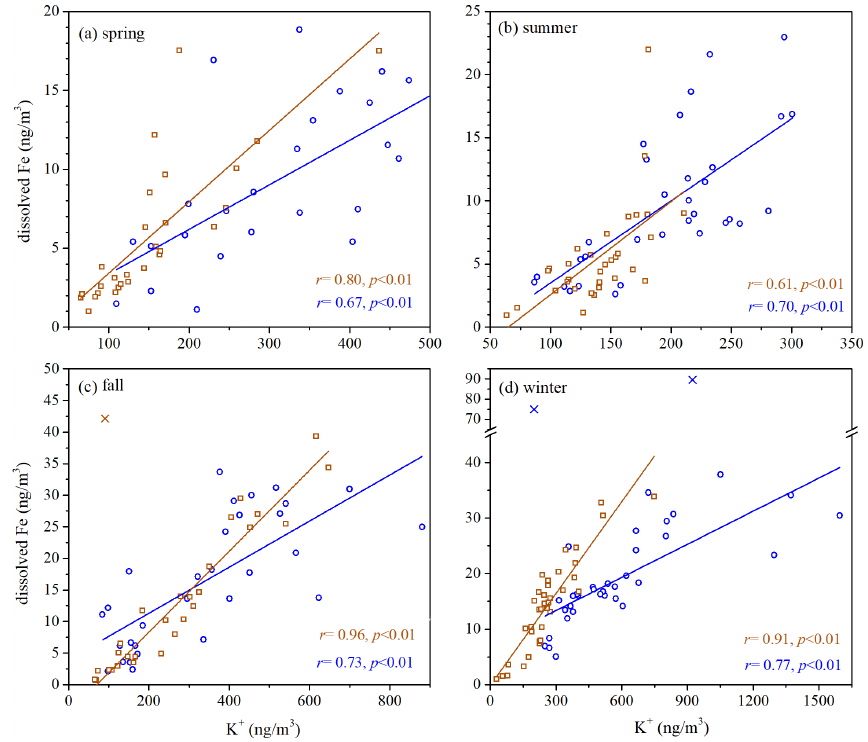
Figure 3. Dissolved Fe versus K + for fine and coarse particles in different seasons: (a) spring; (b) summer; (c) fall; (d) winter. Blue symbols represent fine particles, and brown symbols represent coarse particles. Cross symbols represent data points which are not included in fittings.